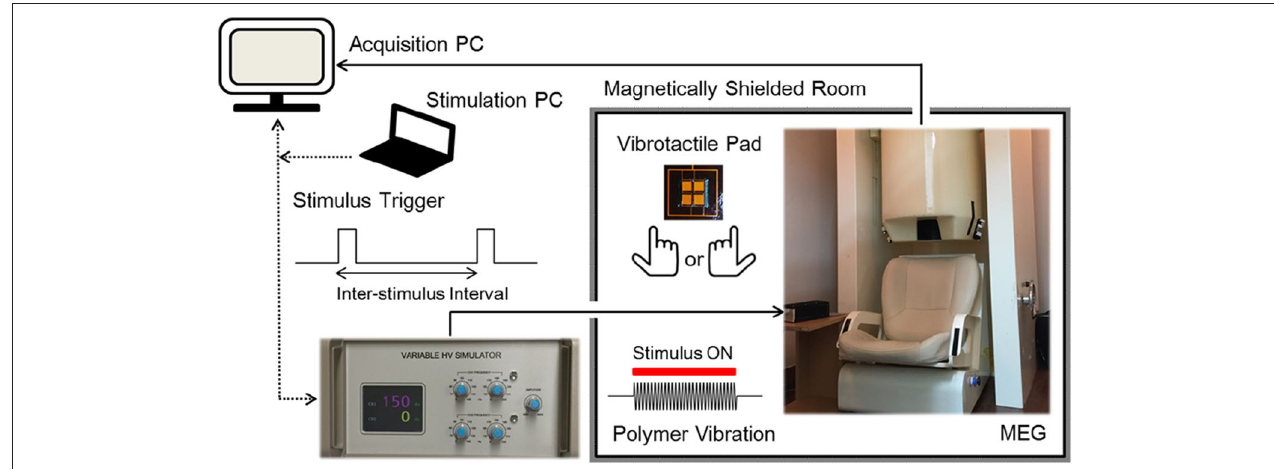
FIGURE 1 | Experimental setup. Participants were comfortably seated on a chair in a magnetically shielded room with their heads placed inside a helmet of an MEG dewar. Sinusoidal vibrations were presented to the tip of the left index finger or the right index finger in two separate sessions, in a counterbalanced order. A total of 300 stimuli were applied at 150 Hz for a 200 ms duration with random inter-stimulus intervals between 1.6 and 2.4 s [see Kim et al. (2019) for